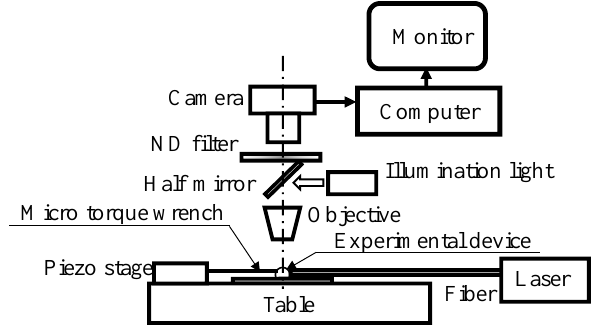
Figure 4. Overview of the experimental measurement system.